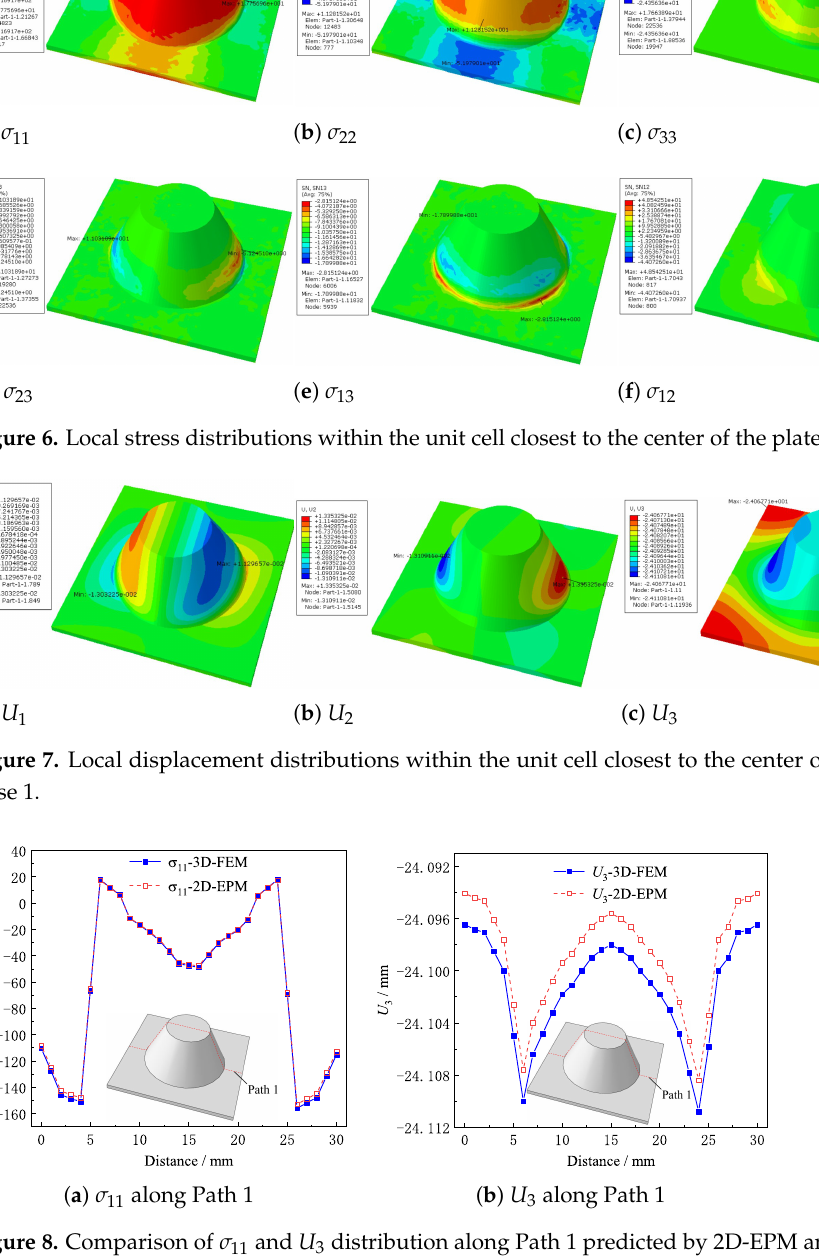
Figure 8. Comparison of σ 11 and U 3 distribution along Path 1 predicted by 2D-EPM and